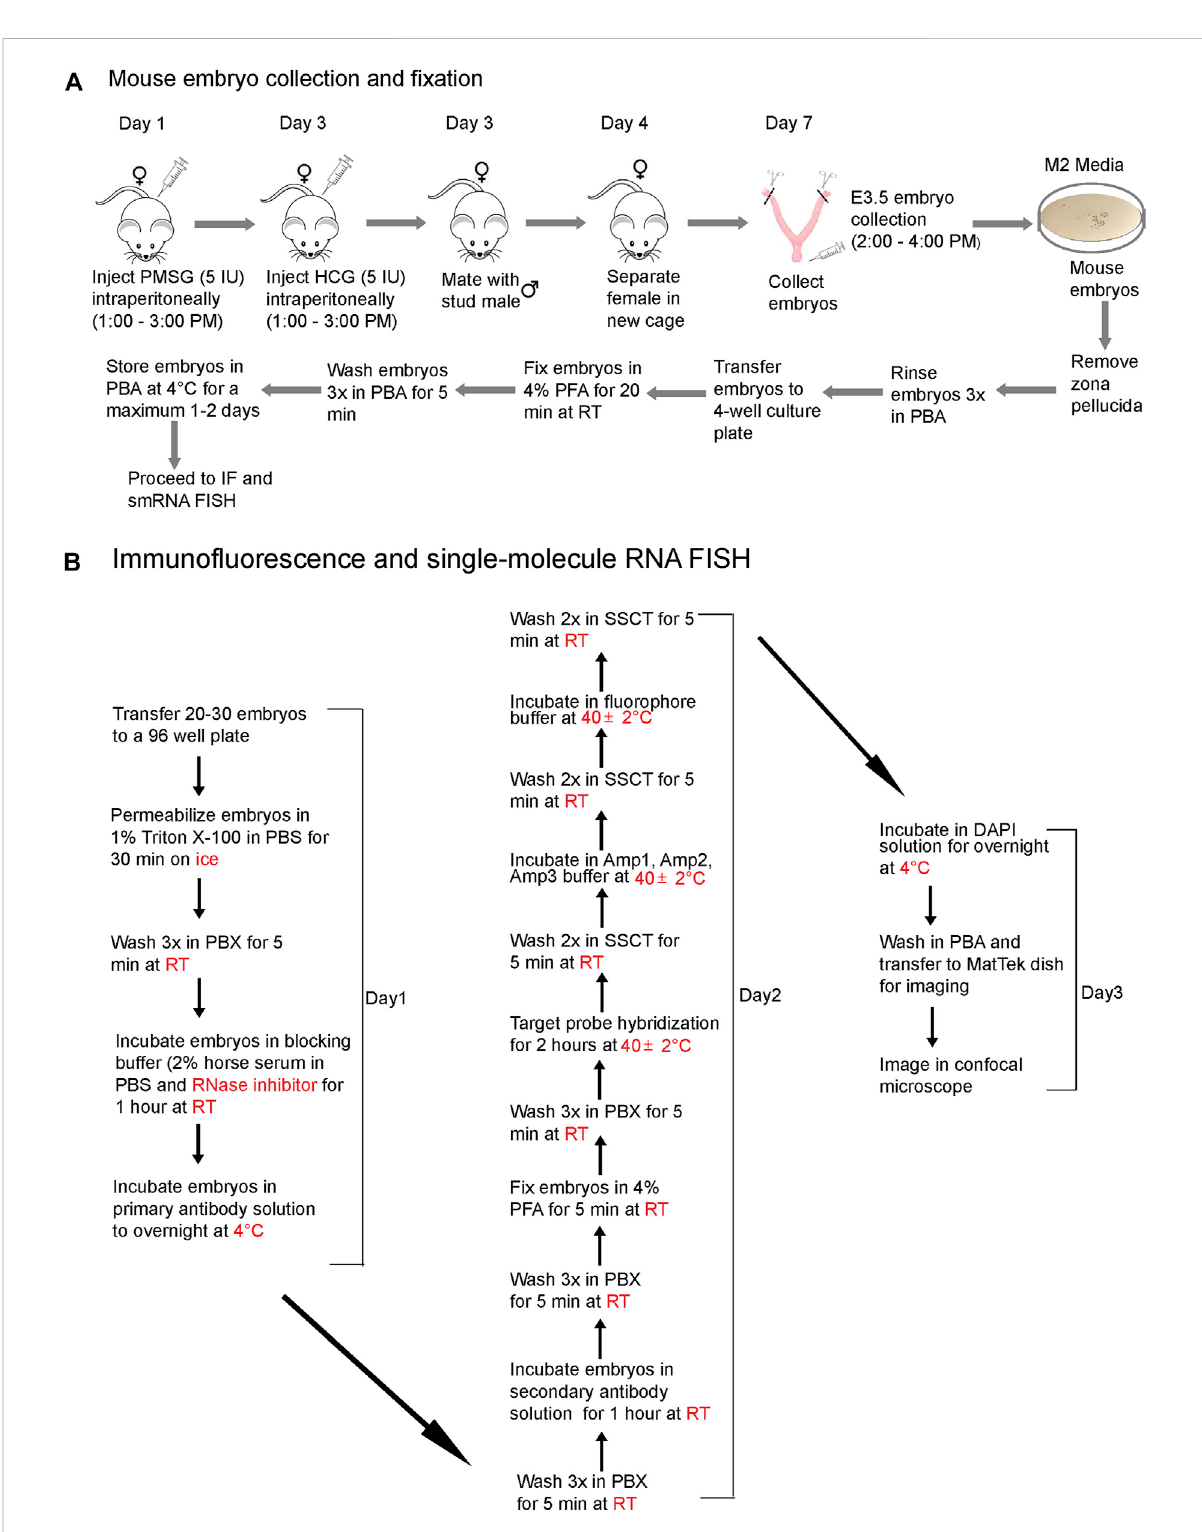
FIGURE 1 A work fl ow diagram for (A) mouse embryo collection and fi xation and (B) the IF and smRNA FISH protocol.